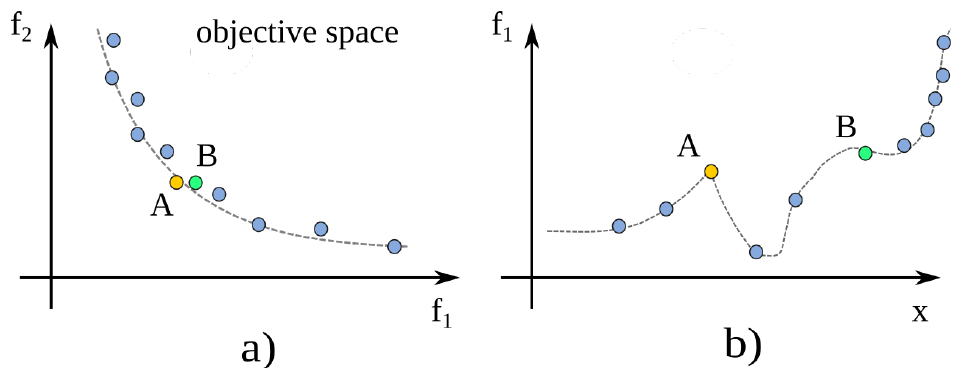
Figure 4. Illustration of a Pareto-front of a multiobjective optimization task. Two solution are highlighted by yellow and green color, where the yellow is sensitive and the green robust to the changes of the parameter x. In case ( a ) sensitive and robust solutions are close to each other and ( b ) solutions are distant from each other